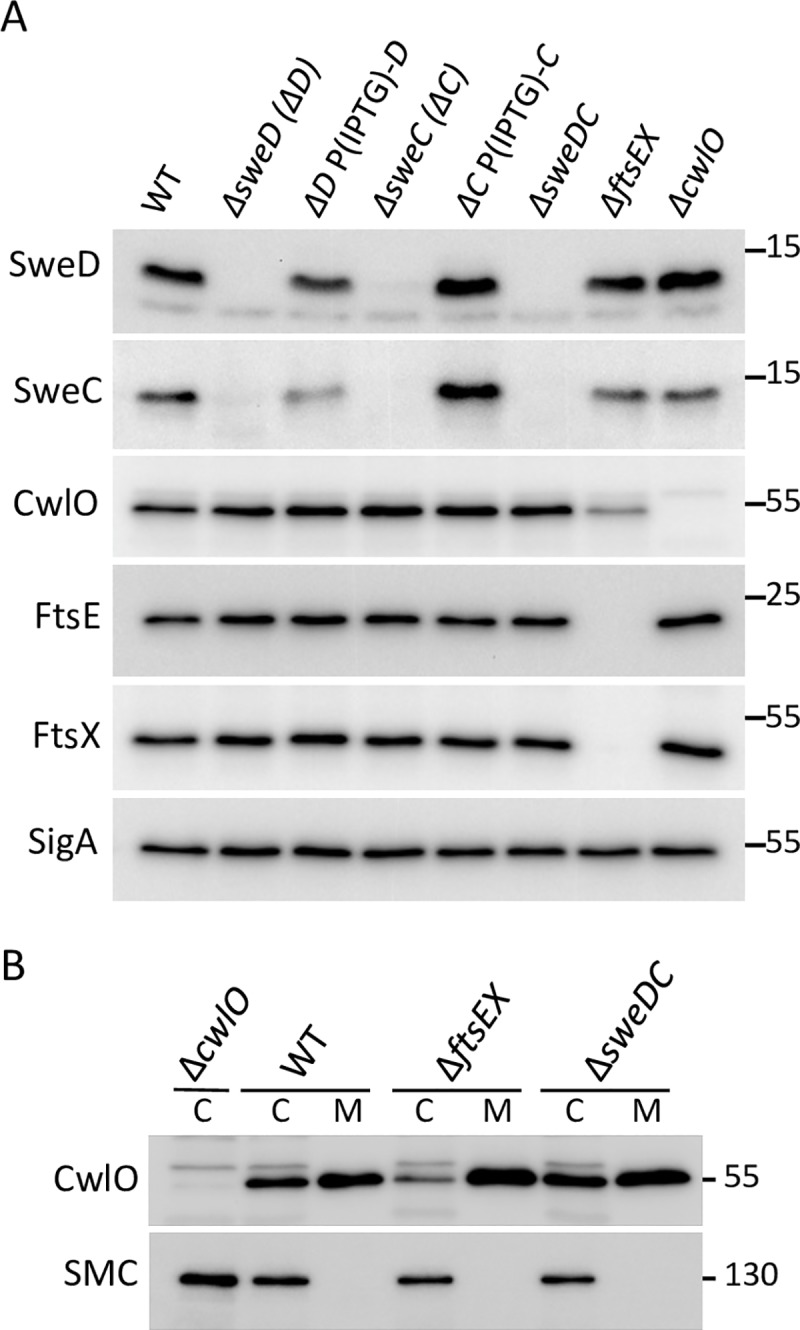
SweD and SweC depend on each other for stability.(A) Immunoblot analysis of SweD and SweC in different mutant backgrounds. The indicated strains were grown in LB medium to mid-exponential phase and SweD, SweC, CwlO, FtsE, FtsX and SigA were assessed by immunoblot analysis. SweC levels were almost undetectable in cells lacking SweD (ΔD) but were largely restored when SweD was produced under IPTG control [P(IPTG)-D] from an ectopic locus. Similar results were obtained for SweD in cells lacking SweC (ΔC). By contrast, the levels of FtsE, FtsX, and CwlO were unaffected by the absence of SweD and/or SweC. CwlO levels were partially reduced in the absence of FtsEX. The SigA immunoblot serves to control for loading. The immunoblots shown are from one of three independent experiments. (B) Cell-association of CwlO partially depends on FtsEX but not on SweDC. Immunoblot analysis of wild-type (PY79) and cells lacking cwlO (BJM54), ftsEX (BJM272) and sweDC (BYB339). Strains were grown in LB medium to mid-exponential phase and equivalent amounts of whole cell lysate (C) and culture medium (M) concentrated by trichloroacetic acid precipitation were separated by SDS-PAGE. CwlO and the cytoplasmic protein SMC were assessed by immunoblot analysis. The SMC immunoblot serves to control for loading. See Methods for a detailed protocol describing how CwlO was recovered from the medium and the plastic microfuge tube where it bound non-specifically during culture collection. The immunoblots are from one of three independent experiments. Molecular weight markers (in kDa) are indicated.